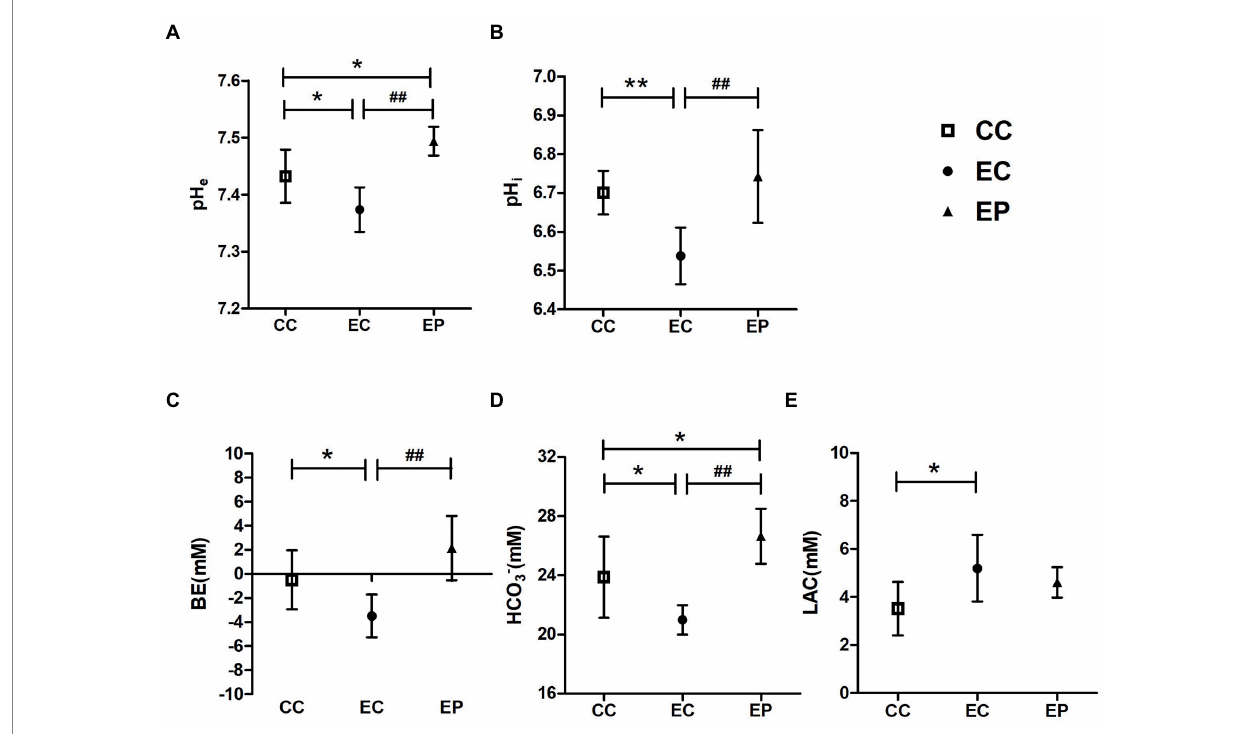
FIGURE 2 Effect of exogenous pyruvate pre-supplementation on (A) blood pH (pH e ), (B) muscle pH (pH i ), (C) base excess (BE), (D) HCO 3 − , (E) lactic acid (LAC) levels in high-intensity interval exercise rats. *Significantly different to control non-exercise (CC) group ( p < 0.05). **Significantly different to control non-exercise (CC) group ( p < 0.01). ## Significantly different to control HIIE (EC) group ( p < 0.01).